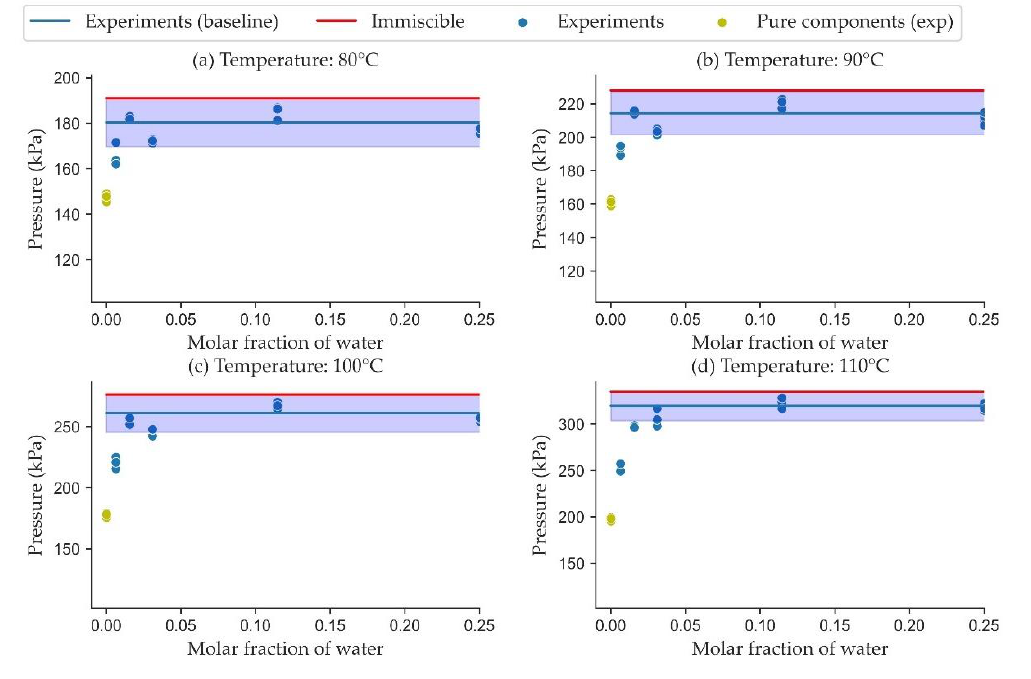
Figure A3. P mix for Highly Diluted Water in Octane Mixtures at 80 °C, 90 °C, 100 °C, 110 °C.